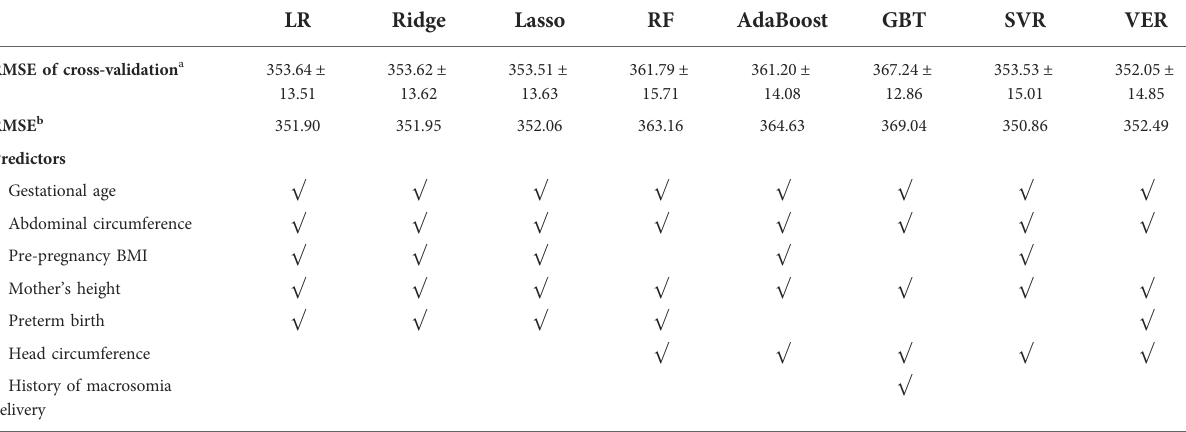
TABLE 3 Root mean squared error and the 5 most important predictors for the prediction of infant birth weight using 8 machine learning methods after considering ultrasound-measured fetal